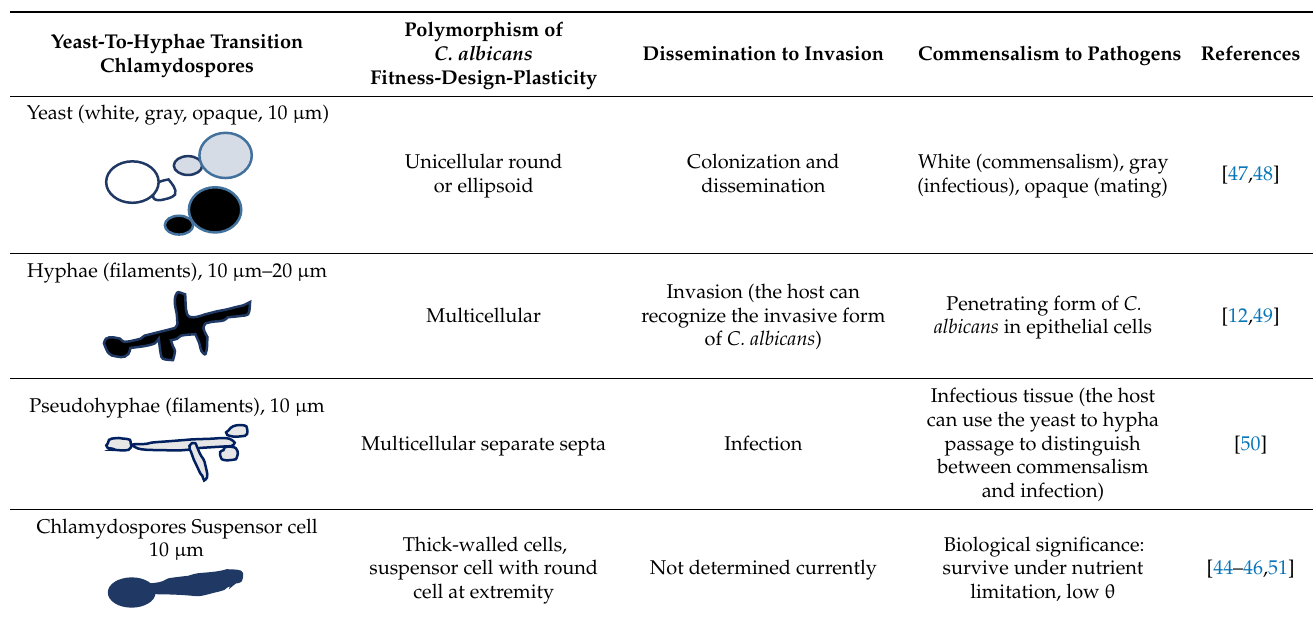
Table 1. The host can detect the invasive form from commensalism to infection by recognizing the passage from yeast to hyphae. C. albicans has the capacity to adapt its morphology according to the local conditions of the oral cavity (pH, θ , nutrients). Several forms—cellular, pseudohyphae, or true hyphae—allow Candida to proliferate and invade tissues. C. albicans can differentiate to form chlamydospores, enlarged thick-walled cells, under nutrient limitation, low temperature, and micro aerophilia.